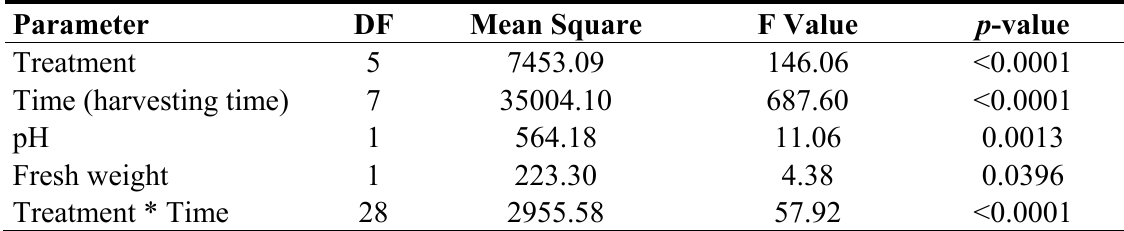
Table 1. ANOVA test for experimental parameters influencing phenolic acids